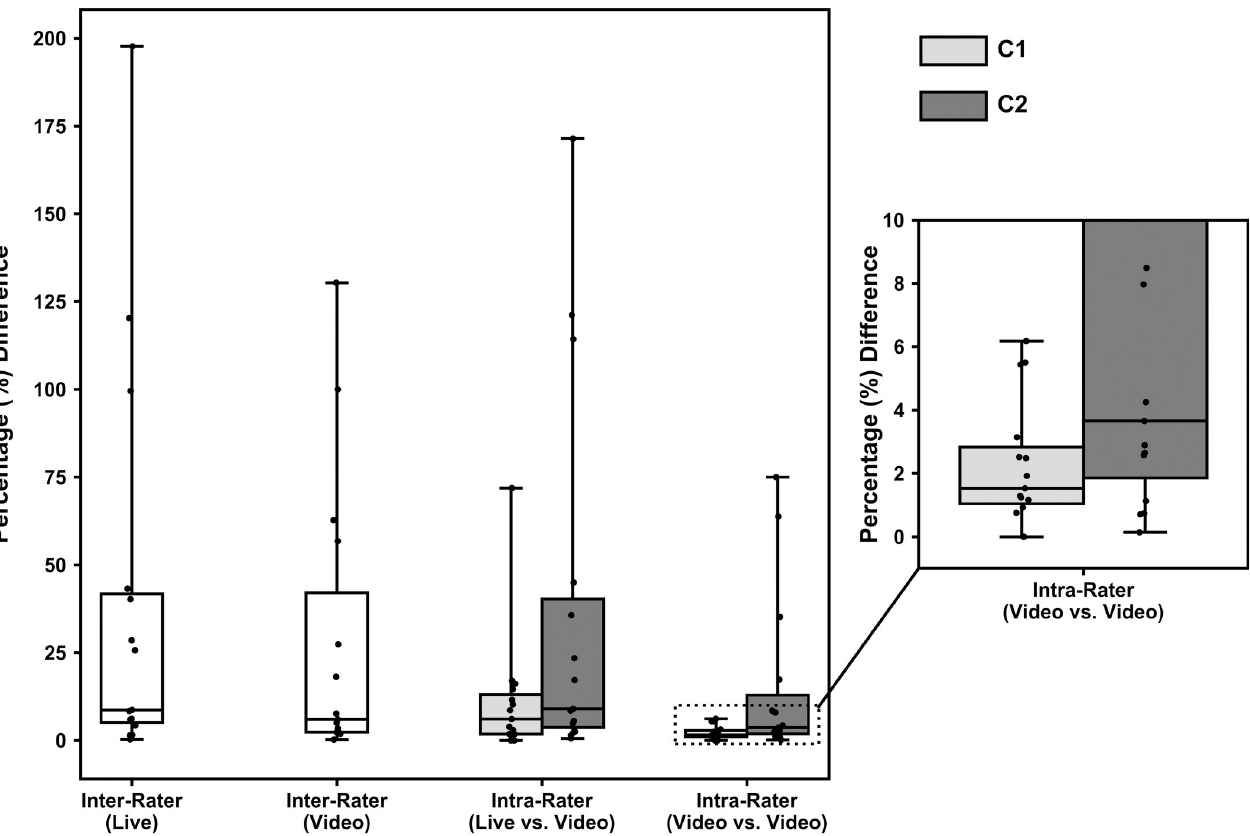
Fig 2. Agreement between coders and conditions. The horizontal line within boxes represents the median value, while the outer borders of the box represents the 25 th to 75 th quartiles of the data. Error bars represent the 1.5 inter-quartile range. Individual frequency counts are specified by the singular plotted points.